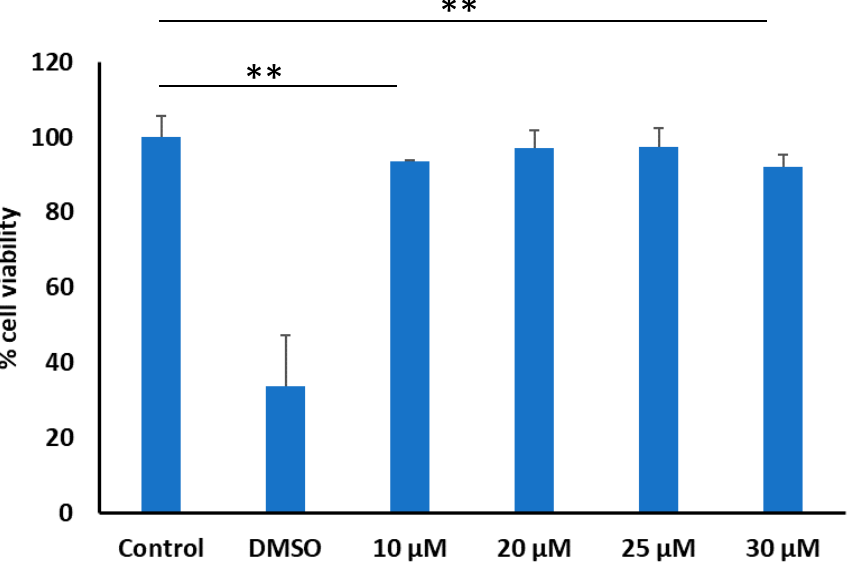
Figure 2. Cytotoxicity of tricyclic peptide 20 in MDA-MB-231 cells (if p < 0.01 then **). DMSO (35% v / v ) was used as the positive control. The compound was used in the aqueous solution.